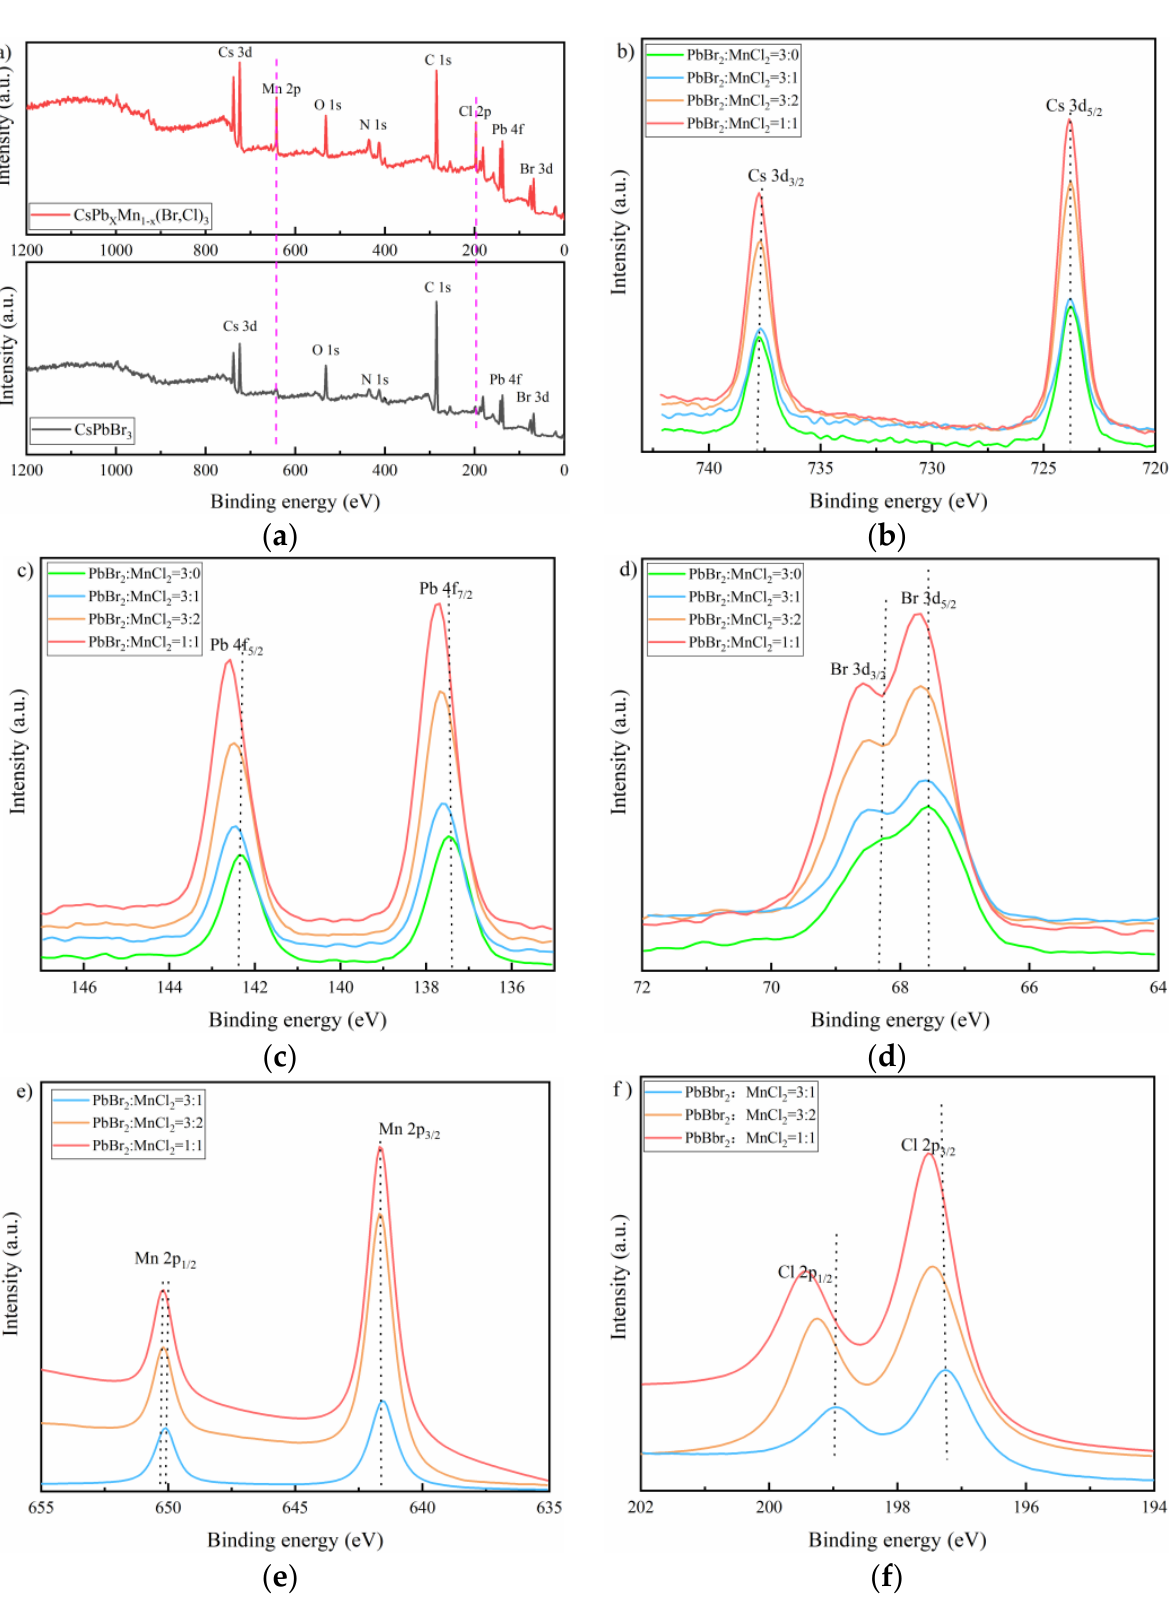
Figure 4. ( a ) XPS survey spectra of Mn-doped and undoped samples; the combining energy of different elements: ( b ) Cs 3d, ( c ) Pb 4f, ( d ) Br 3d, ( e ) Mn 2p, and ( f ) Cl